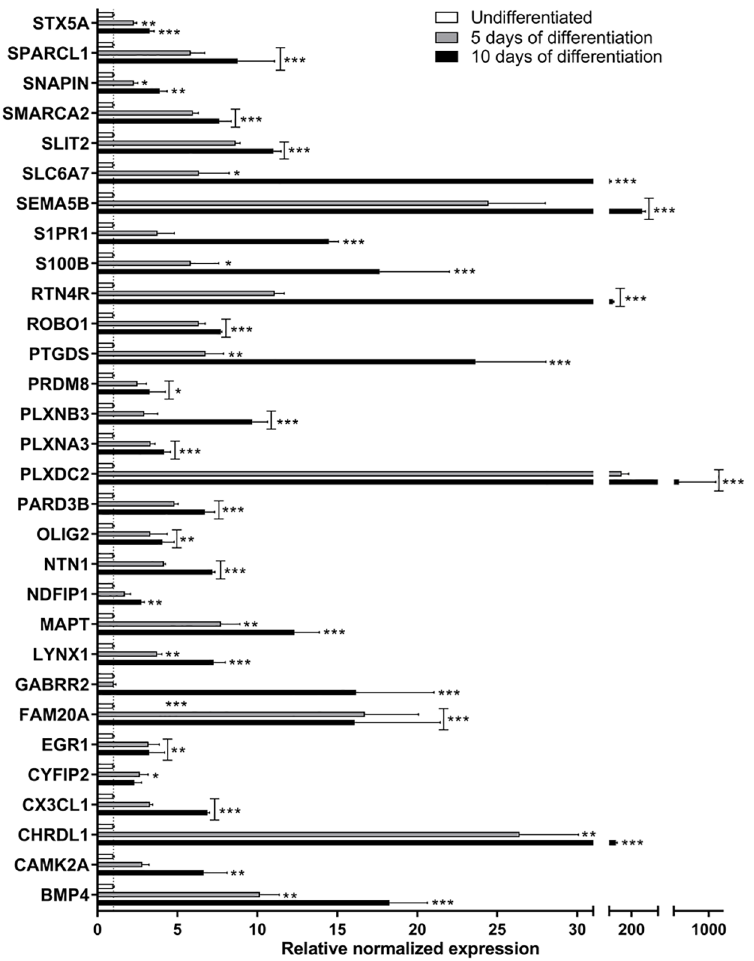
Fig 5. RT-qPCR validation of the 30 selected genes important for differentiation of the C17.2 cell line. The data are presentedas the mean of 3 independent experiments. Results were analyzedusing two-way ANOVA followedby Dunnett’s multiple comparisons test. The bars representthe mean ± SEM. * p (cid:20) 0.05, ** p (cid:20) 0.01, *** p (cid:20) 0.001 comparedto undifferentiated cells (unfilledbar).